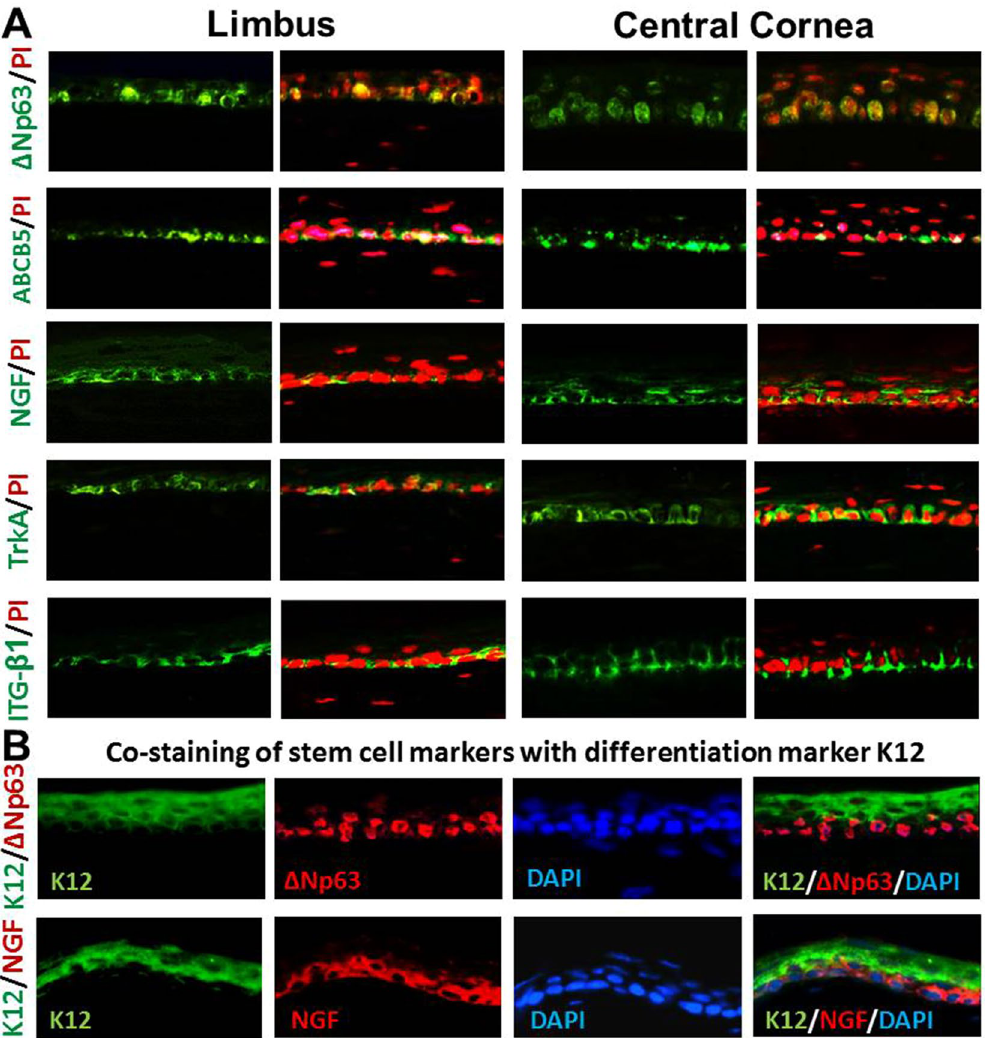
Figure 2. Representative images of Immunofluorescent staining of stem cell markers. ( A ) Five proposed stem/ progenitor cell markers, Δ Np63, ABCB5, NGF, TrkA and integrin β 1 (ITG- β 1), were mainly expressed by some basal epithelial cells in both limbus and central cornea. ( B ) Double staining with corneal specific marker K12 and stem cell markers Δ Np63 and NGF. Image magnification: 400 ×